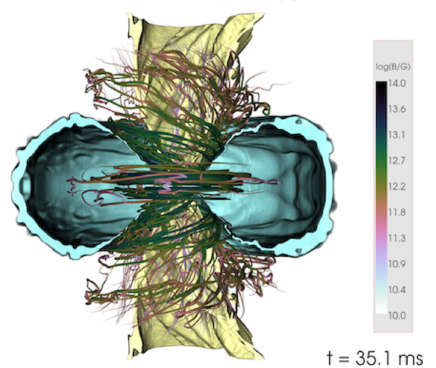
Figure 4. The magnetic field structure for a model from [134] depicted at 35.1 ms after merger. Two isosurfaces of density are shown in yellow (10 8 g/cm 3 ) and cyan 10 10 g/cm 3 ). The field lines are colored by magnetic field strength. The toroidal field inside the torus is easily seen, together with a poloidal funnel above the BH. This model collapsed to a BH at t BH ∼ 8.7 ms after merger. Due to the limited resolution, the KH instability is not entirely accounted for in these simulations. (Reprinted with permission from [134]. c (cid:13) (2016) by the American Physical Society).